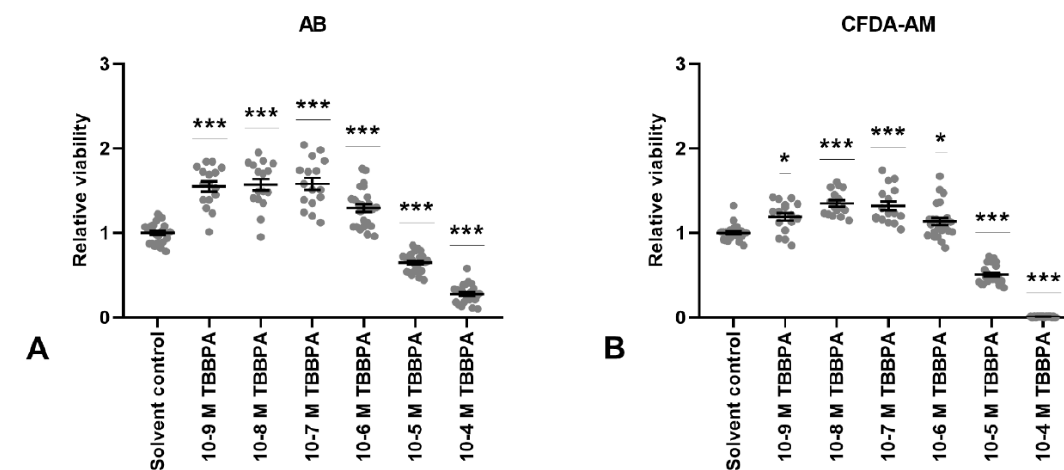
Figure 4. Viability in terms of metabolic activity (AB assay; ( A )) and membrane integrity (CFDA-AM assay; ( B )) in Atlantic cod pituitary cells after 7 days of primary culture w / wo tetrabromobisphenol A (TBBPA) added to the culture media for the last 72 h. Each data point represents the sample fold change relative to mean solvent control. For each column, the group mean ± SEM is indicated ( n = 16–24). Statistical significance (* p < 0.05, *** p < 000.1) was assessed using the Kruskal–Wallis test followed by the Steel method.